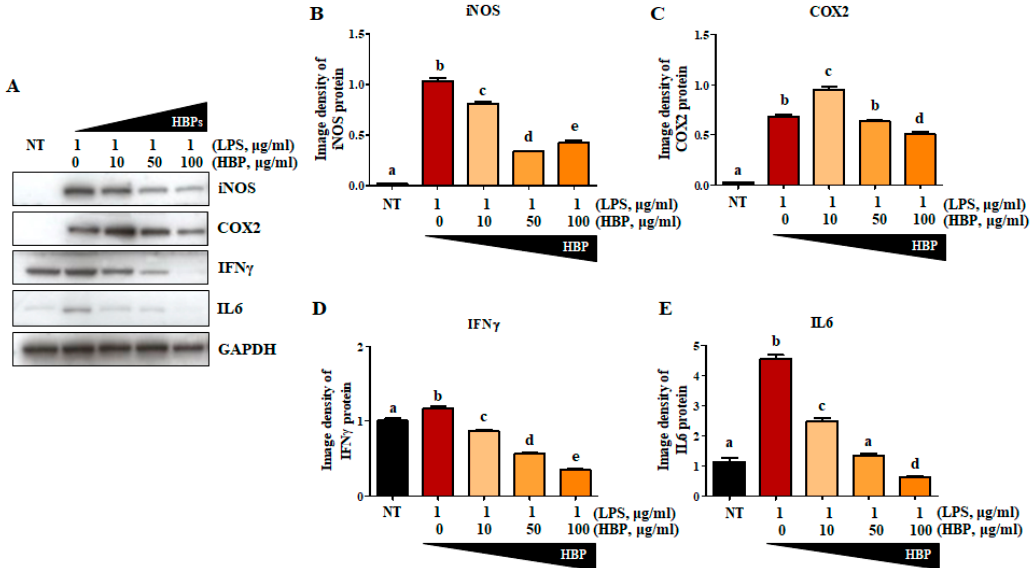
Figure 4. Effects of HBP on inflammatory marker protein expression in LPS-stimulated RAW264.7 macrophages. ( A ) Western blot analysis of inflammatory markers, including iNOS, COX2, IFN γ , and IL6, in LPS-stimulated RAW264.7 cells. ( B – E ) Band intensity of each protein (iNOS ( B ), COX2 ( C ), IFN γ ( D ), and IL6 ( E )) presented as a bar graph normalized to the intensity of the corresponding GAPDH band ( n = 3). Different alphabets (a, b, c, d, and e) in each Figure indicate significant differences among experimental groups ( p < 0.05).